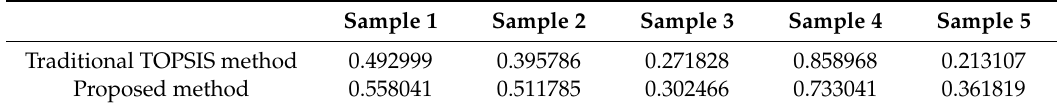
Table 6. Comparison of evaluation